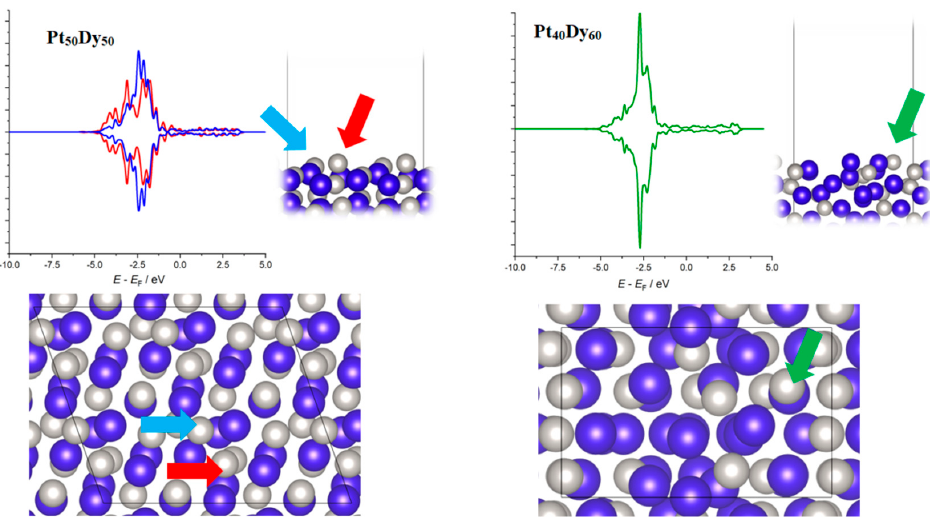
Figure 5. Exposed Pt pair on the Pt 50 Dy 50 surface ( left ) and exposed Pt atom on the Pt 40 Dy 60 surface ( right ), with the corresponding projected densities of states (PDOS). Grey—Pt, blue—Dy atoms.